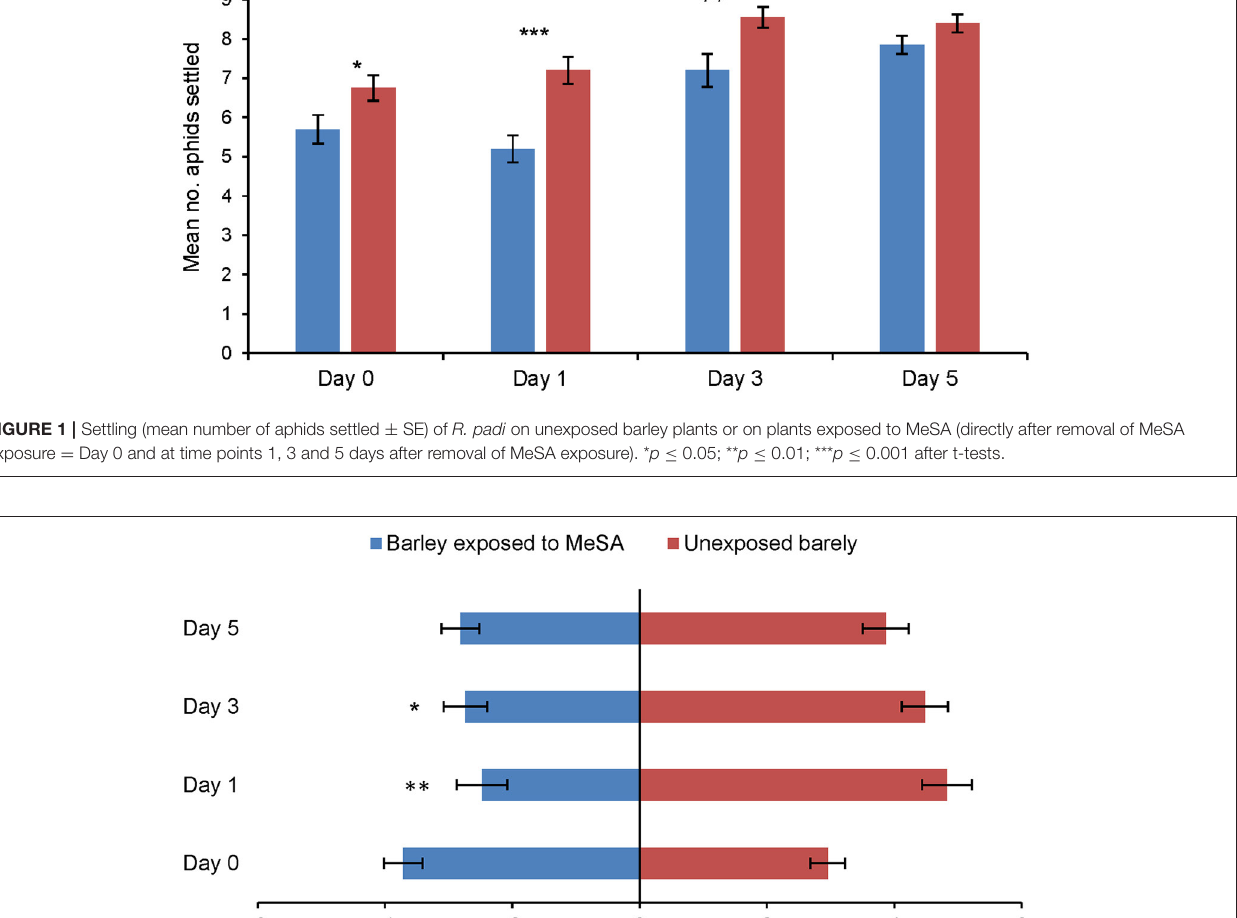
while probing period was shorter ( p = 0.023) in MeSA-exposed plants than unexposed ( Supplementary Table 2C ). The effect was mainly due to a significantly shorter duration of feeding period (E2) in exposed plants ( p = 0.03). The number of long sustained feeding periods ( > 10 and 60 mins) was significantly higher in unexposed plants ( p = 0.037; p = 0.048). A further indication of resistance to feeding in MeSA-exposed plants is the longer time between the 1st E1 and 1st E12 (sustained feeding) period ( p = 0.013). This means that aphids took a longer time to establish a successful feeding period in exposed plants. Five days after removal of MeSA (Day 5), the EPG results show no significant effects of plant exposure to MeSA on aphid probing ( Supplementary Table 2D